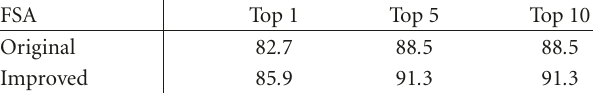
Table 7: Retrieval accuracy [%].